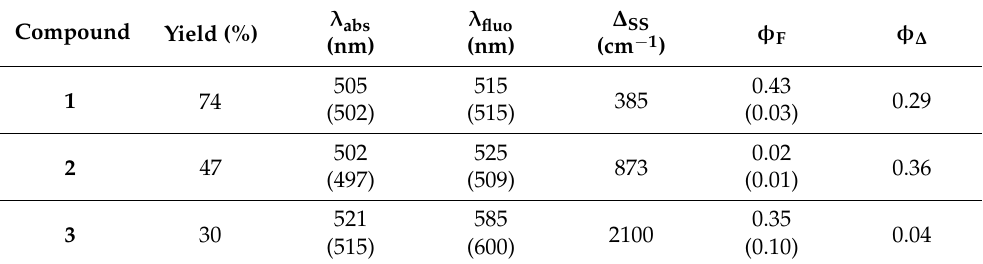
Table 1. Synthesis and photophysical data (including absorption, λ abs , and fluorescence emission maxima, λ fluo , fluorescence quantum yields, φ F , Stokes-shift, ∆ SS , and singlet oxygen sensitization quantum yields, φ ∆ ) for the BODIPY derivatives 1 – 3 , in tetrahydrofuran solution and acetonitrile (data in brackets) at 293